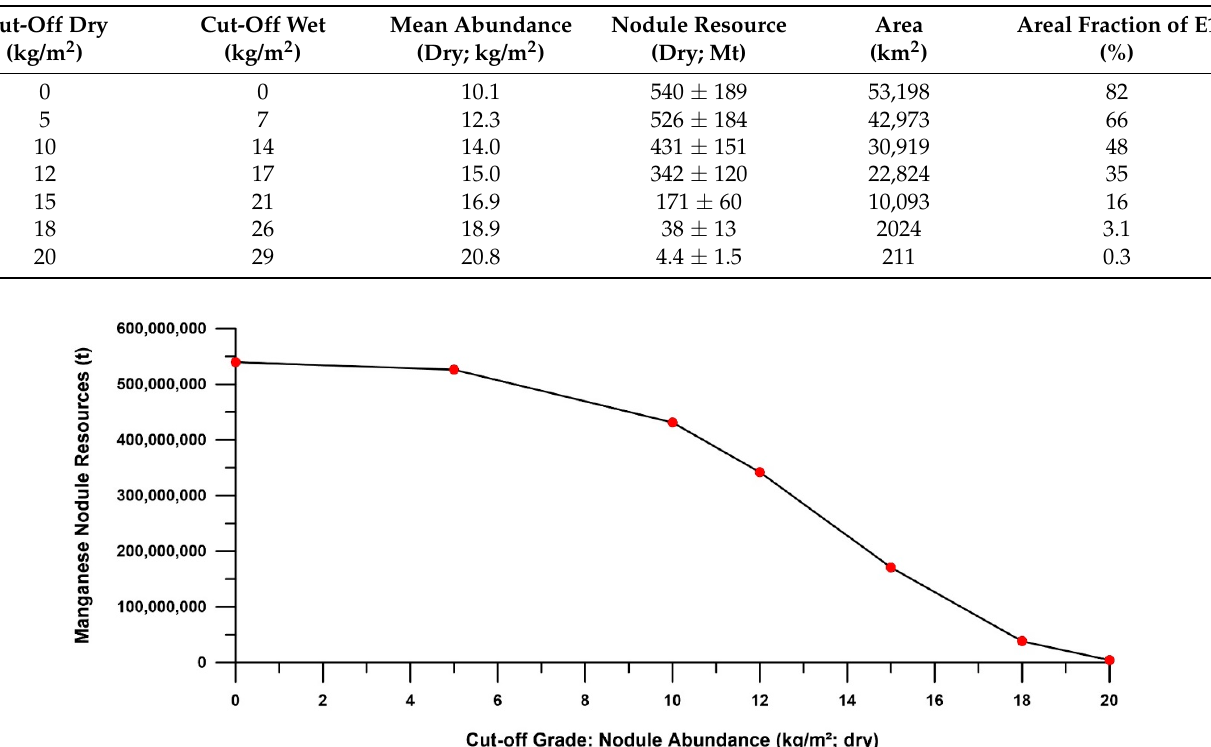
Table 4. Overview of the estimated metal resources in Area E1 at different cut-off values (based on dry weight). Cut-Off Grade Mn Nodule Abundance (Dry, kg/m 2 ) Element Metal Resource in Area E1 Table 3. Total Mn nodule resource (on dry weight basis) in the eastern part of Area E1 calculated with different cut-off values and a relative uncertainty of 35%.